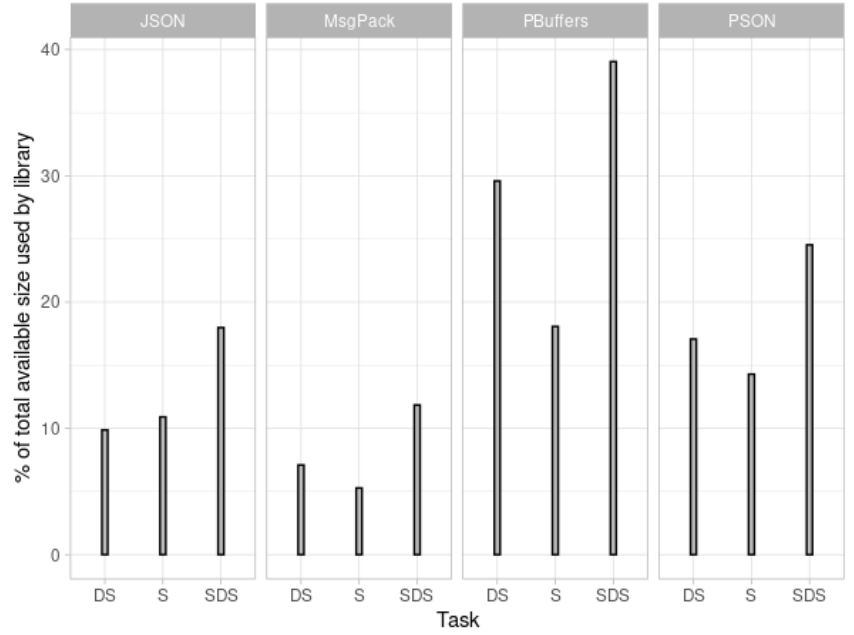
Figure 6. Arduino binary size